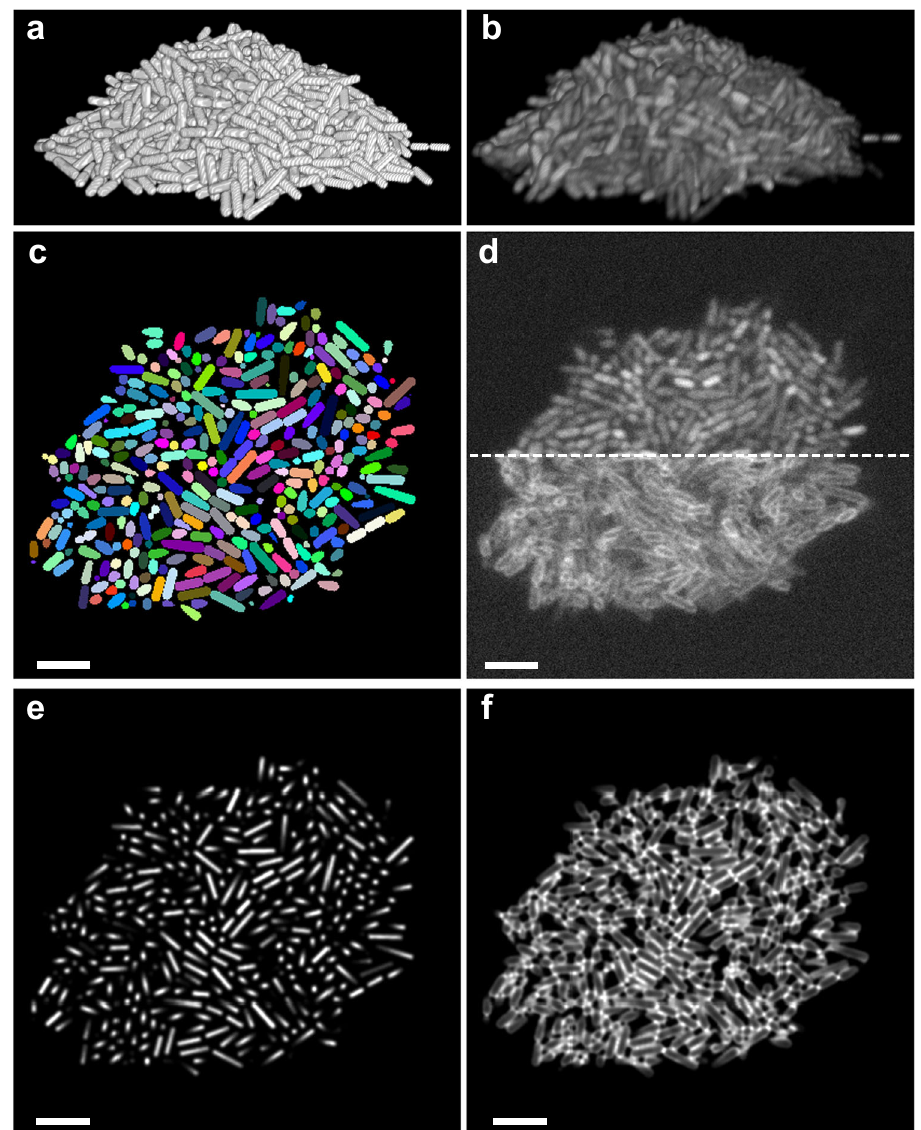
Fig. 5 Simulation of fl uorescent bio fi lms images and intermediate image representations. a Cell arrangements obtained by CellModeller. b Simulated 3D fl uorescence image based on the cell arrangements in a . c Ground truth information of a 2D slice. Different cells are shown in different colors and intercellular spaces (background voxels) are displayed in black. d 2D slices of the simulated fl uorescence image corresponding to the ground truth shown in c . The upper panel shows cells containing cytosolic fl uorophores, the lower panel shows cells with fl uorescently stained membranes. e , f Intermediate image representations generated from the ground truth information shown in c . See text for details. Scale bars are 5